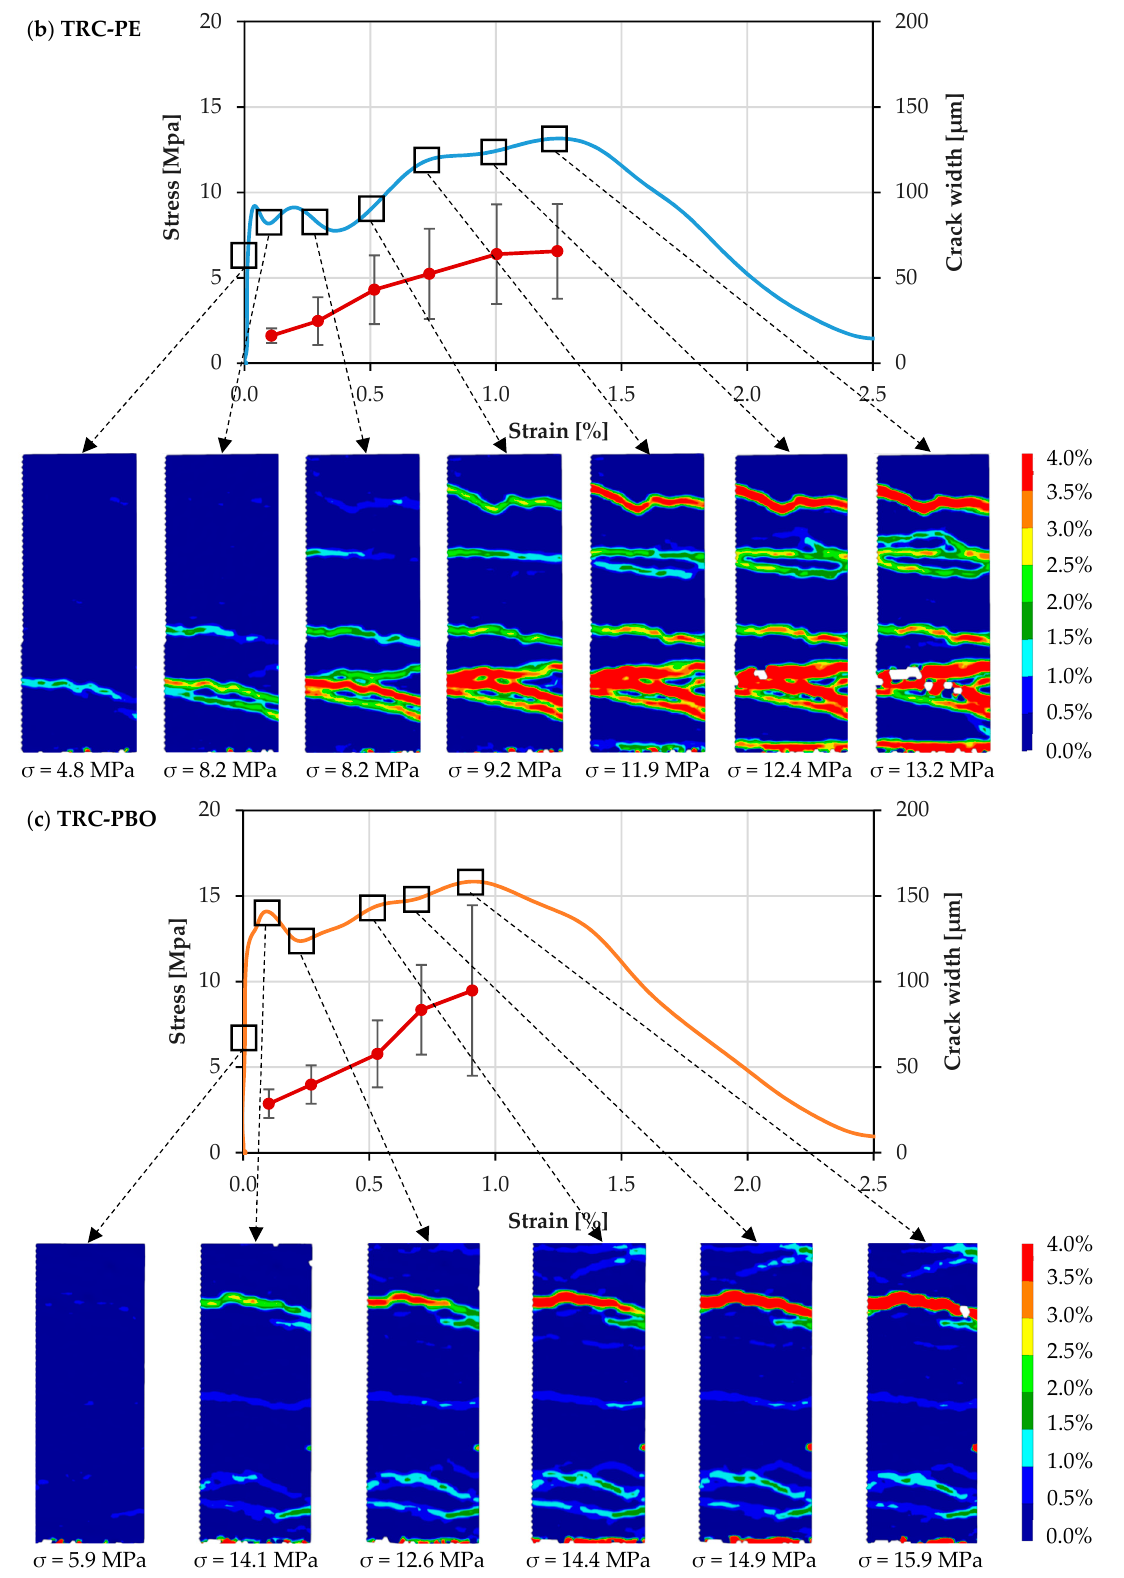
Figure 11. Tensile stress–strain curve and corresponding average crack widths of a representative specimens of ( a ) TRC-M, ( b ) TRC-PE, and ( c ) TRC-PBO, with corresponding composite stresses and crack patterns under impact loading.